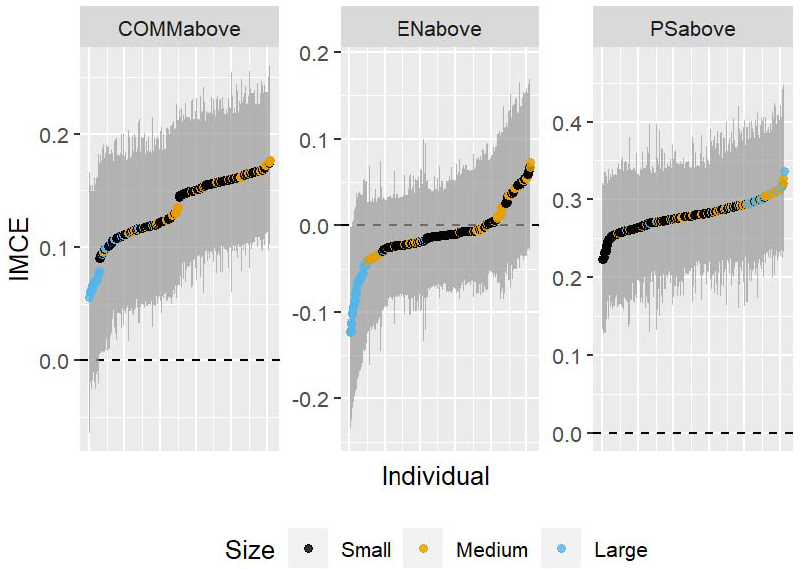
Figure 4. Heterogeneity in IMCE’s by company size covariate.